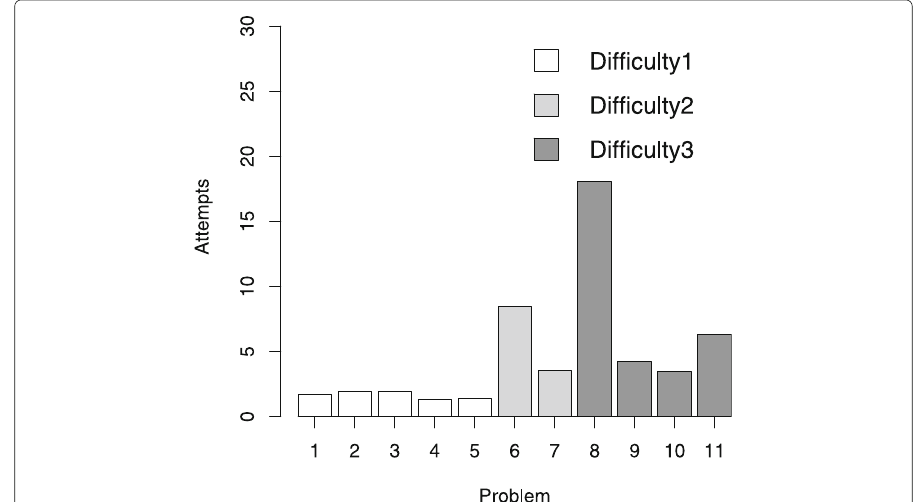
Fig. 6 Average number of tries on level 3-2